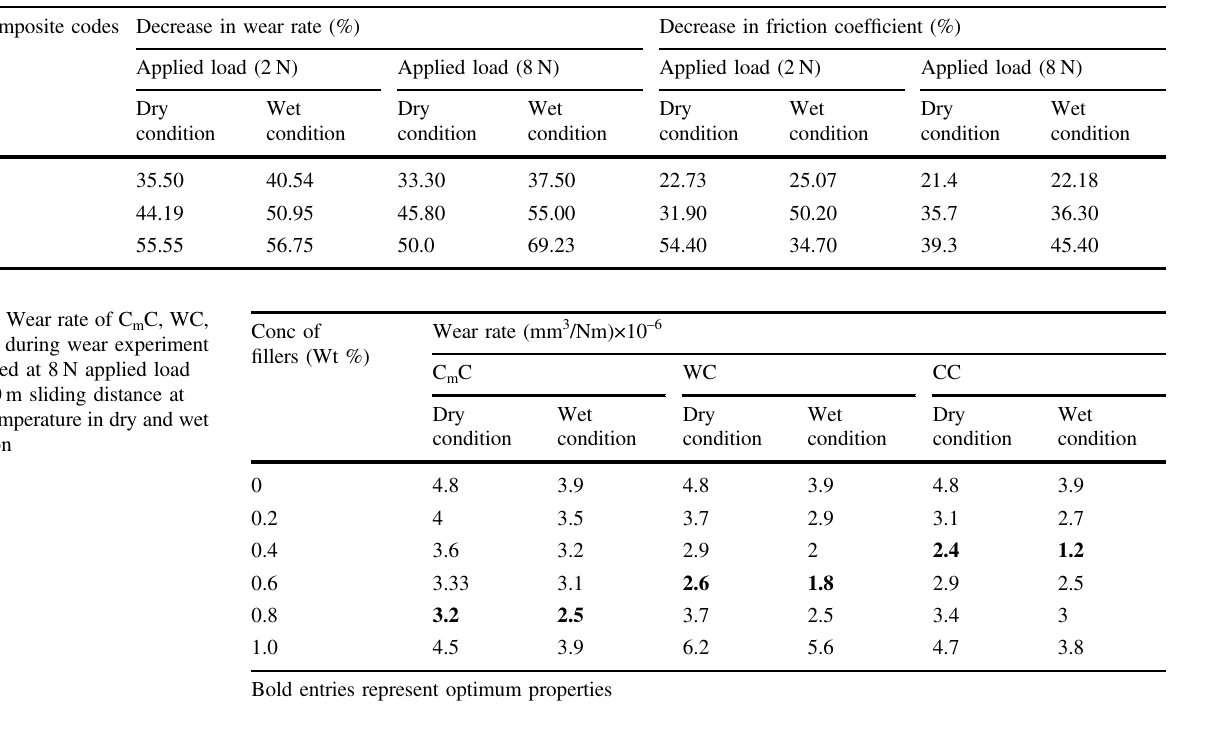
Table 6 COF of C m C, WC, and CC during wear experiment conducted at 8 N applied load and 300 m sliding distance at room temperature in dry and wet